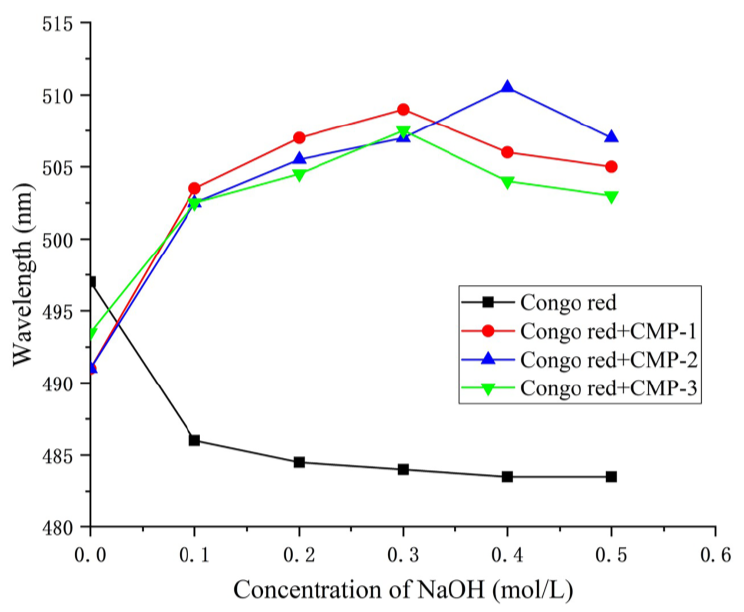
Figure 7. Change of maximum absorption wavelength of Congo red and three polysaccharide com- plexes.